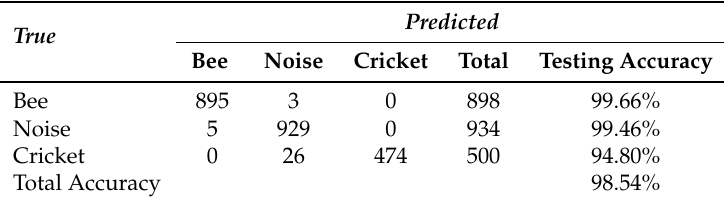
Table 16. Confusion matrix for KNN ( n = 5) on BUZZ2 testing